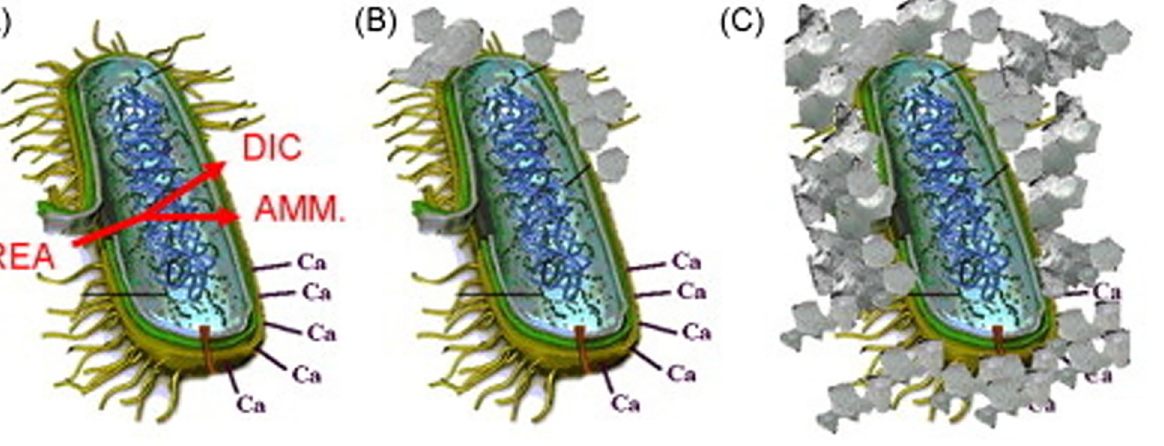
Fig 3. Urease-producing